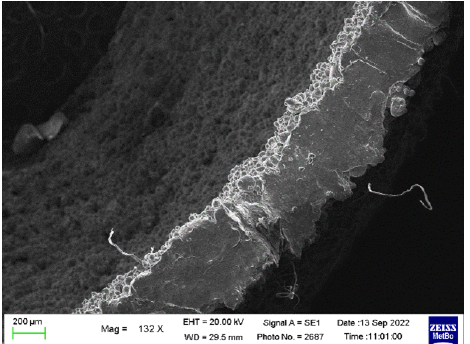
Figure 5. Defect extending through the entire thickness of a 0.6 mm walled